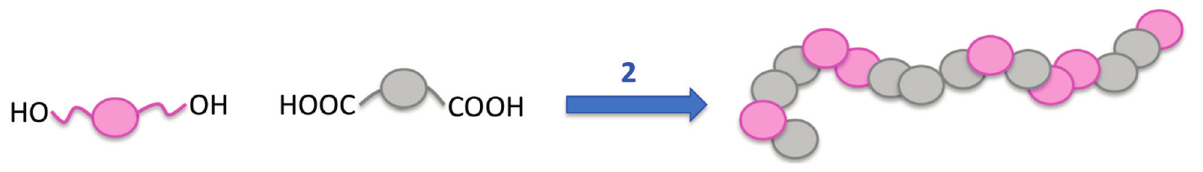
Figure 5. General procedure of polycondensation for the preparation of dye-containing